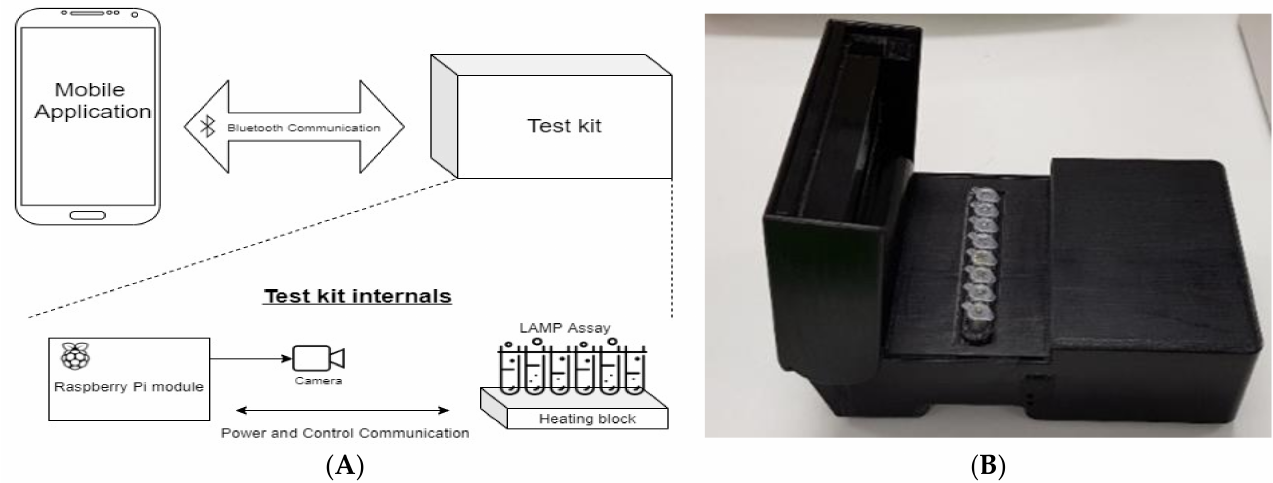
Figure 1. ( A ) System block diagram of low-cost portable molecular diagnostic device proposed for SARS-CoV-2 detection. ( B ) Exterior of the low-cost portable molecular diagnostic